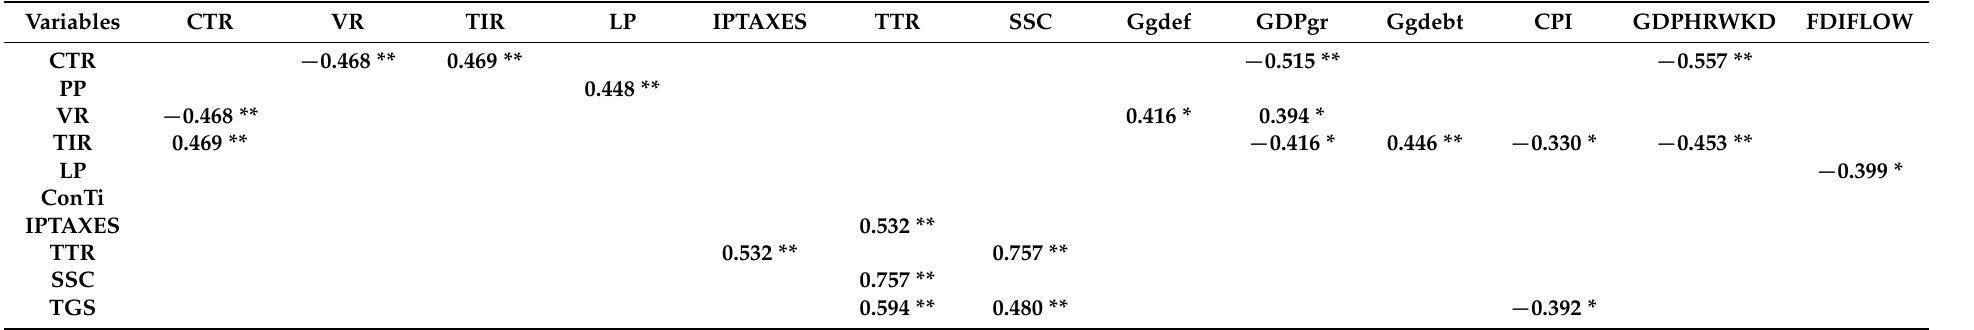
Table 9. Result of the correlation